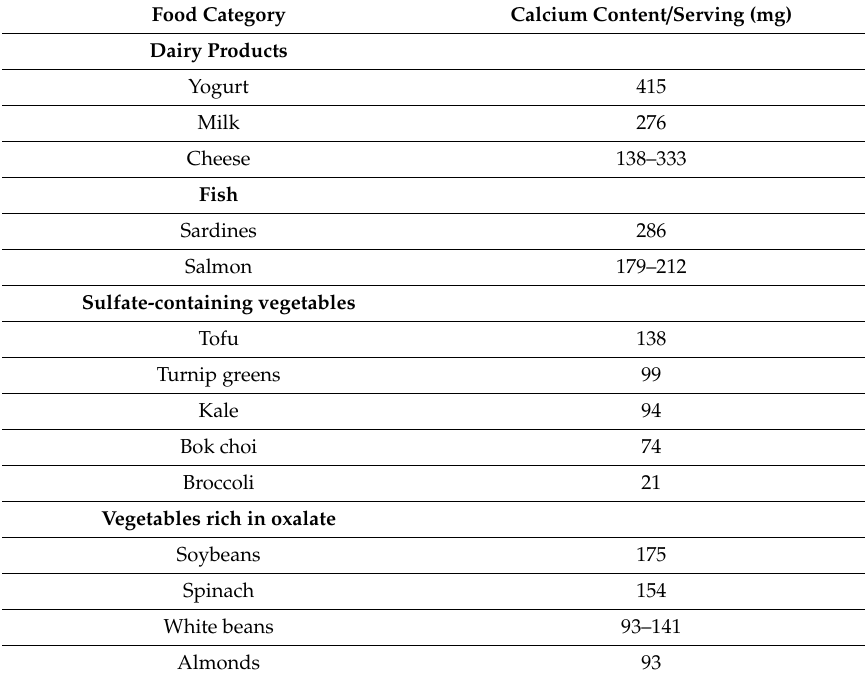
Table 3. Calcium content of